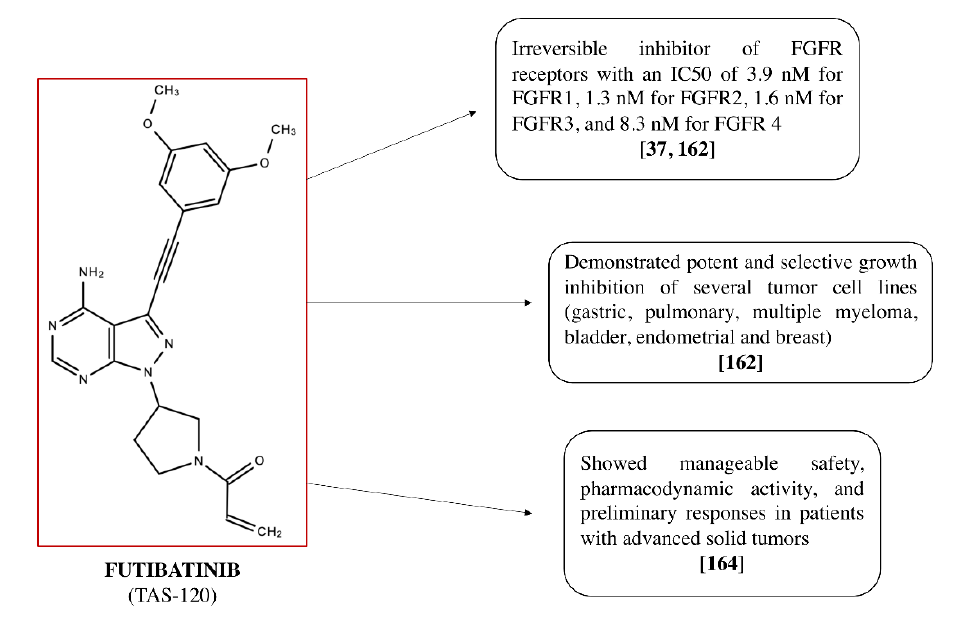
Figure 4. Chemical structure of futibatinib (TAS-120) and its properties.